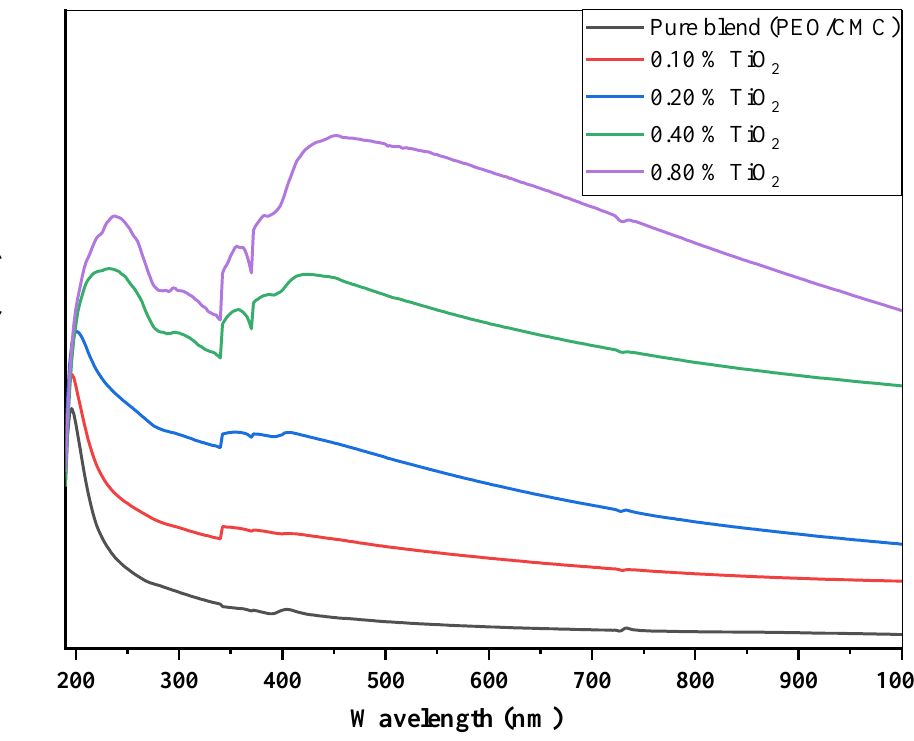
Figure 4. UV/vis spectra of PEO/CMC/TiO 2 NP nanocomposites.